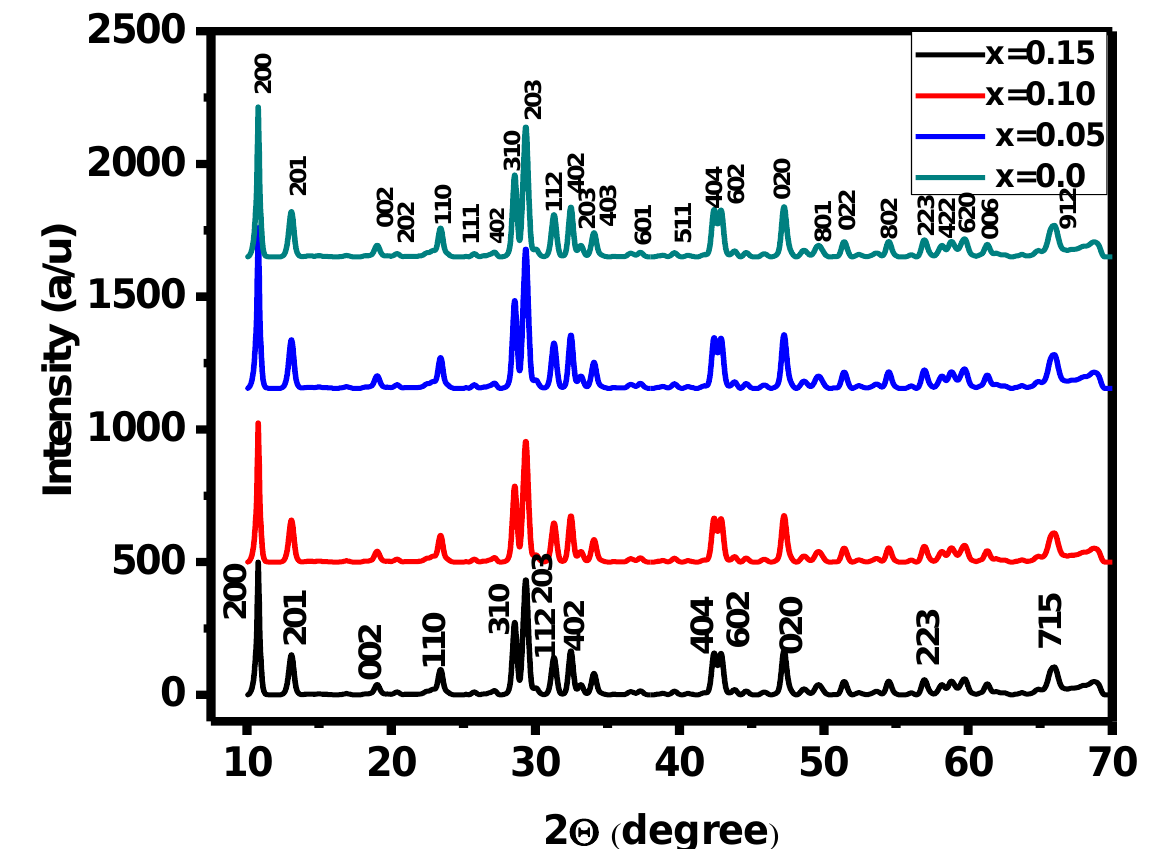
Figure 2. XRD pattern of cobalt-doped K 2 Ti 6 O 13 and K 2 Ti 6 O 13 ceramics. The room-temperature lattice constants of K 2 Ti 6 O 13 and Co: K 2 Ti 6 O 13 ceramics